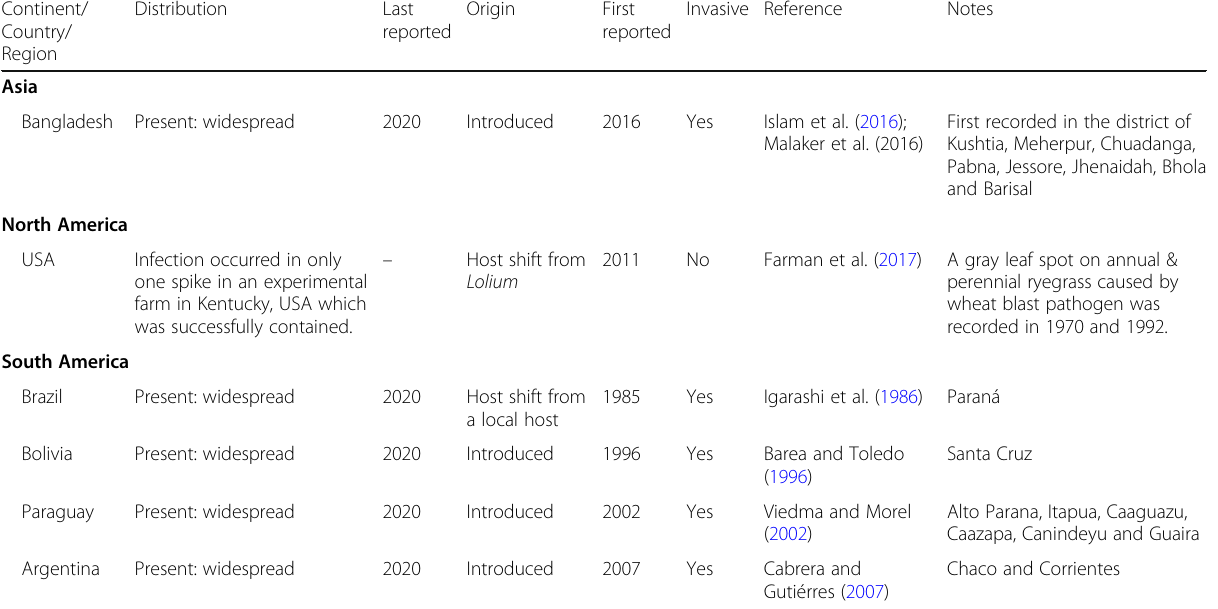
Table 1 Distribution of wheat blast disease across the world Continent/ Country/ Region